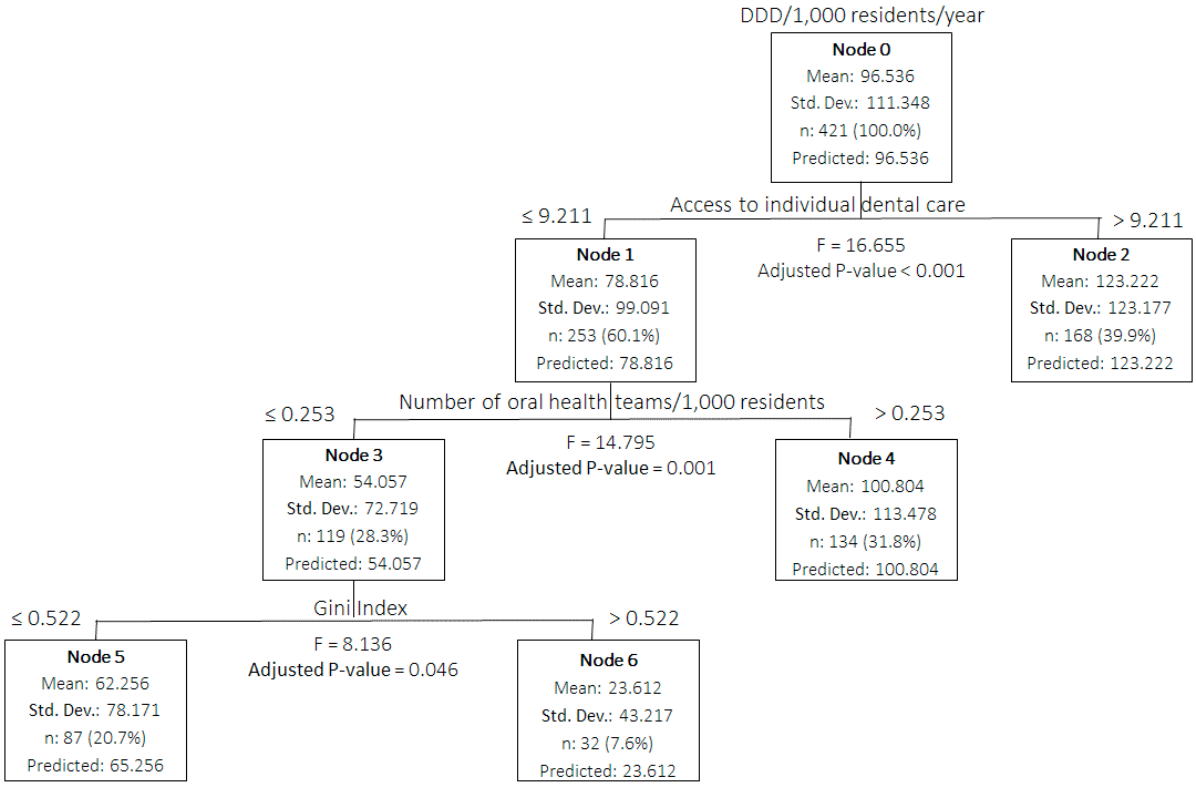
Figure 2. Regression tree of DDD/1,000 residents/year according to independent